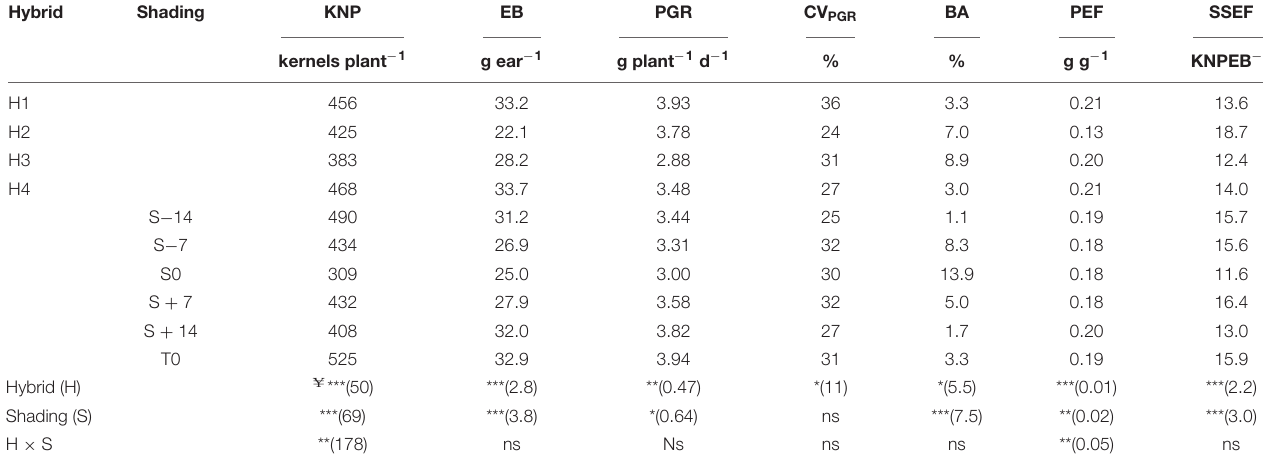
TABLE 2 | Kernel number per plant (KNP), accumulated ear biomass 15 days after anthesis (EB), individual plant growth rate around flowering (PGR) and their coefficient of variation (CVPGR), barrenness (BA), partition efficiency (PEF), and seed set efficiency (SSEF) for the four genotypes (H1, H2, H3, and H4) tested at six shading treatments (S − 14, S − 7, S0, S + 7, S + 14, and T0). Hybrid